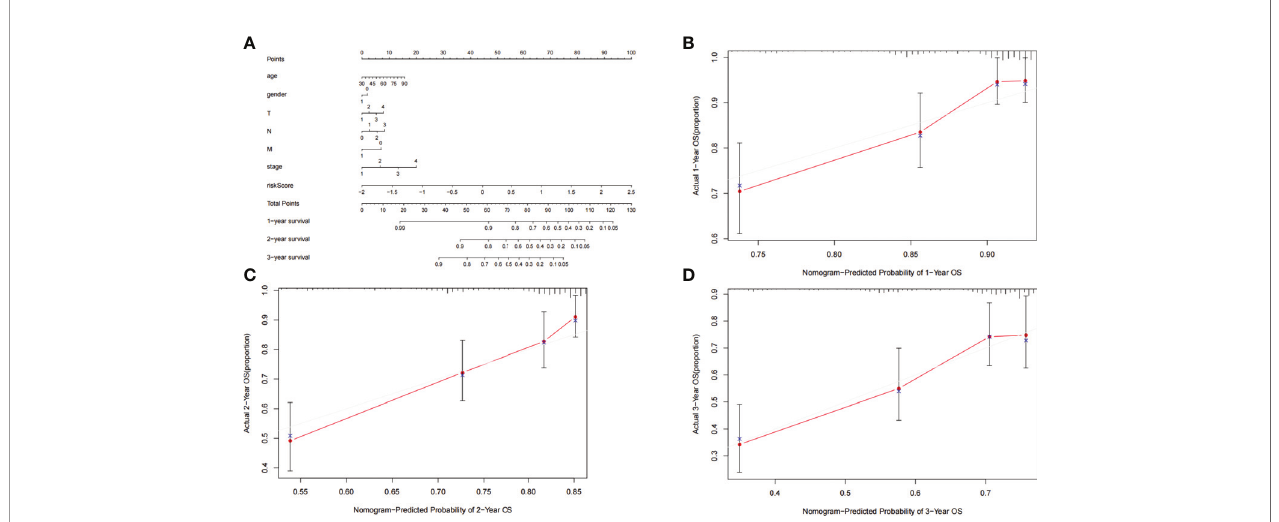
FIGURE 6 | (A) Nomogram was assembled by clinical parameters and risk signature for predicting survival of patients with LUAD. (B) One-year nomogram calibration curves. (C) Two-year nomogram calibration curves. (D) Three-year nomogram calibration